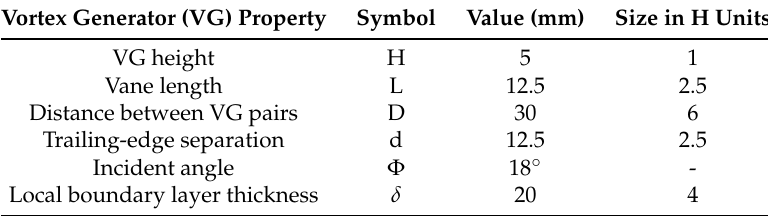
Table 1. Vortex generator geometry used in AVATAR rotor project [18].